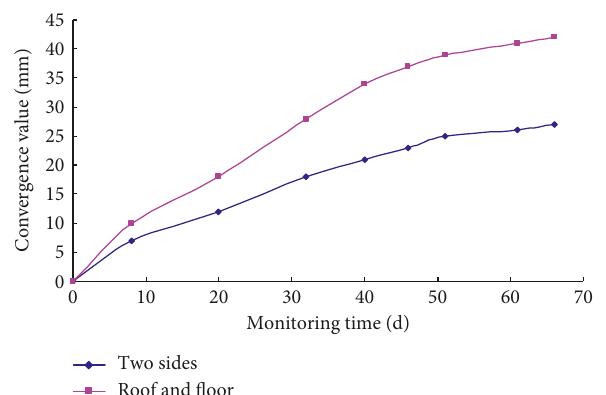
Figure 18: Monitoring curve of the surrounding rock in the chamber of the water pump